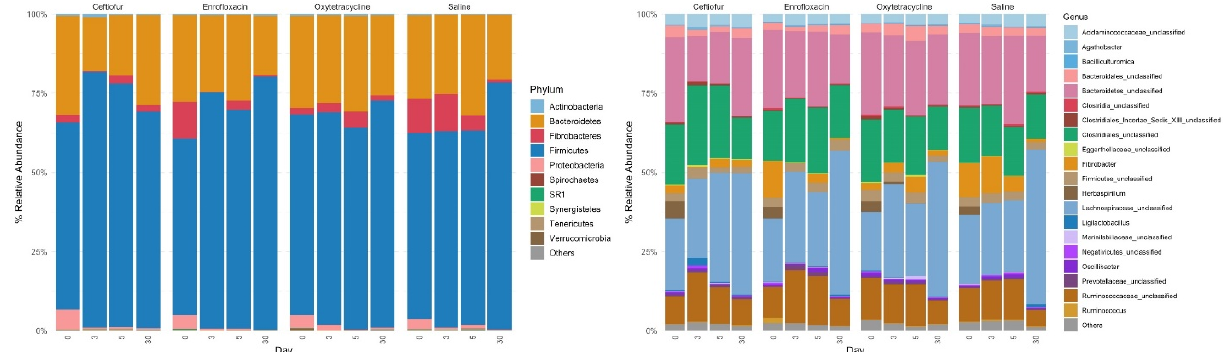
Figure 4. Microbial relative abundances for each treatment group by day. Bacteria were either grouped at phylum or genus level taxonomy. Only top 10 relatively abundant phyla and top 20 relatively abundant genera are shown.